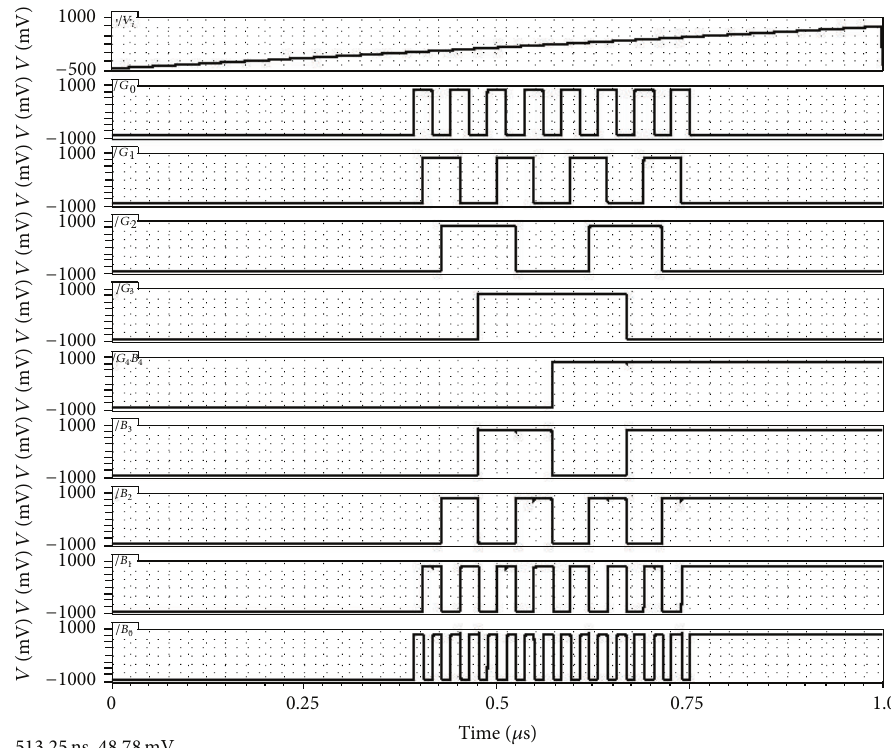
Figure 10: The 5-bit simulation results of flash ADC.